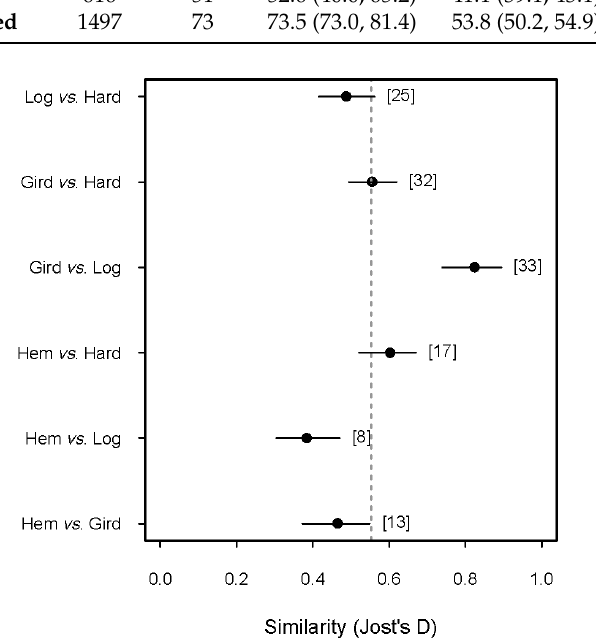
Figure 1. Pairwise similarities in understory species composition (with 95% confidence intervals) between the canopy manipulation treatments in the Harvard Forest Hemlock Removal Experiment. Abbreviations for treatments are: Hem – Hemlock controls; Gird – Hemlocks girdled; Log – Hemlocks cut and removed; Hard – Hardwood controls. Numbers in brackets are the total number of shared species for each pairwise comparison, and the grey dashed line is the average overall pairwise similarity.